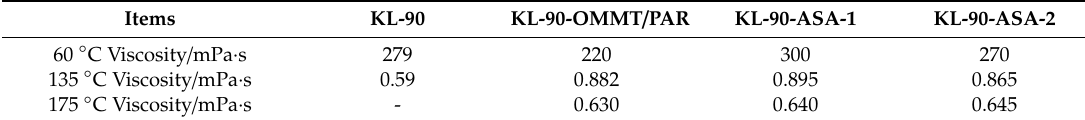
Table 11. Viscosity indices of asphalts with anti-stripping composites.